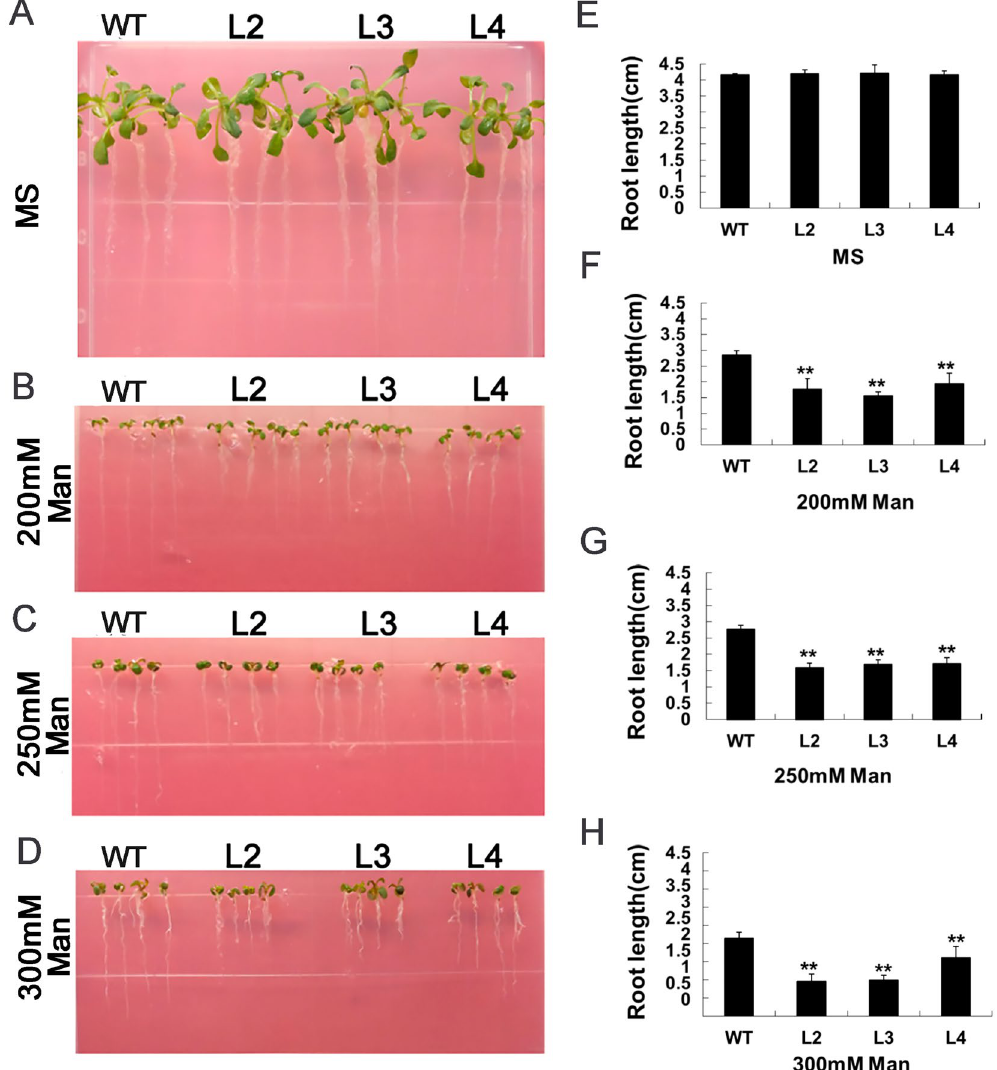
Figure 5. Assay of root length of GhWRKY33 overexpression transgenic Arabidopsis with mannitol treatment. ( A–D) Seedlings of wild type and GhWRKY33 transgenic lines grew on MS medium ( A ), MS medium with 200 mM mannitol ( B ), MS medium with 250 mM mannitol ( C ), and MS medium with 300 mM mannitol ( D ). (E–H) Statistical analysis of root length of wild type and GhWRKY33 overexpression transgenic seedlings grown on MS medium with or without mannitol treatment. Seeds germinated on MS medium for 3 days and then the seedlings were transferred onto MS medium containing different concentration of mannitol for 7 days. Mean values and standard errors (bars) are shown from three independent experiments. Two asterisks represent there was a very significant difference (P < 0.01) in root length between the transgenic lines and wild type. MS, seedlings grew on MS medium without Man as control; 200 mM Man, 250 mM Man, 300 mM Man, seedlings grew on MS medium with 200, 250, and 300 mM mannitol, respectively. WT, wild type; L2, L3 and L4, three GhWRKY33 overexpression transgenic